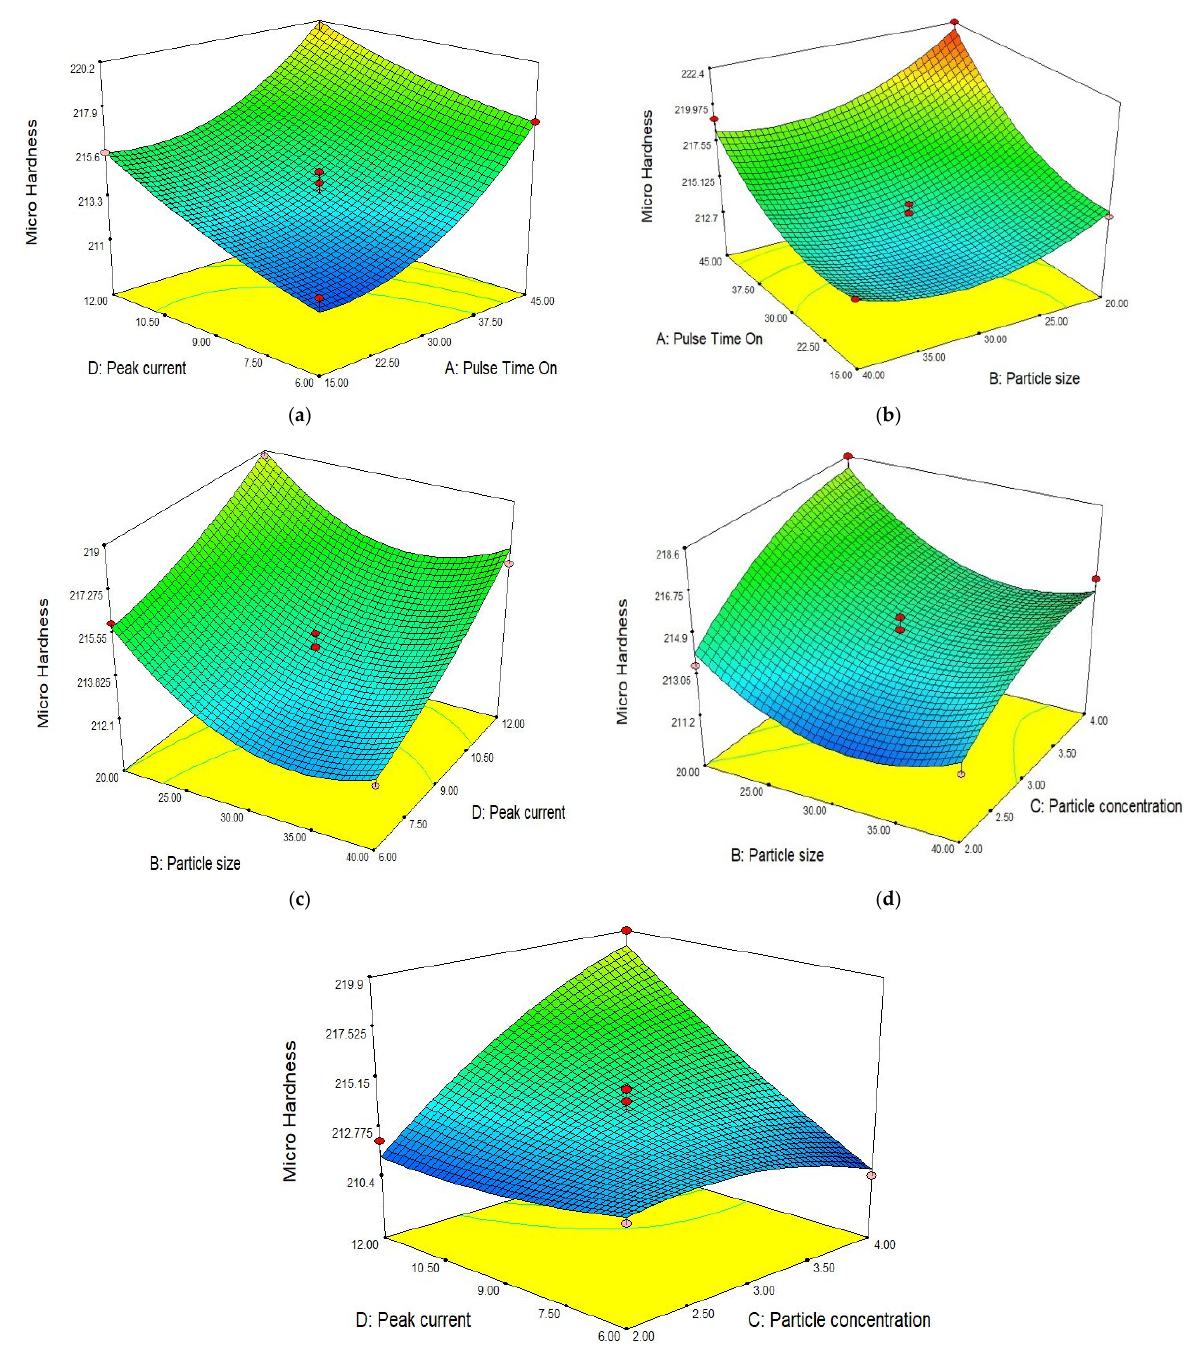
Figure 7. Effect of different parameters on microhardness. ( a ) Peak current vs. pulse time on. ( b ) Particle size vs. pulse time on. ( c ) Particle size vs. peak current. ( d ) Particle size vs. particle concentration. ( e ) Particle concentration vs. peak current.